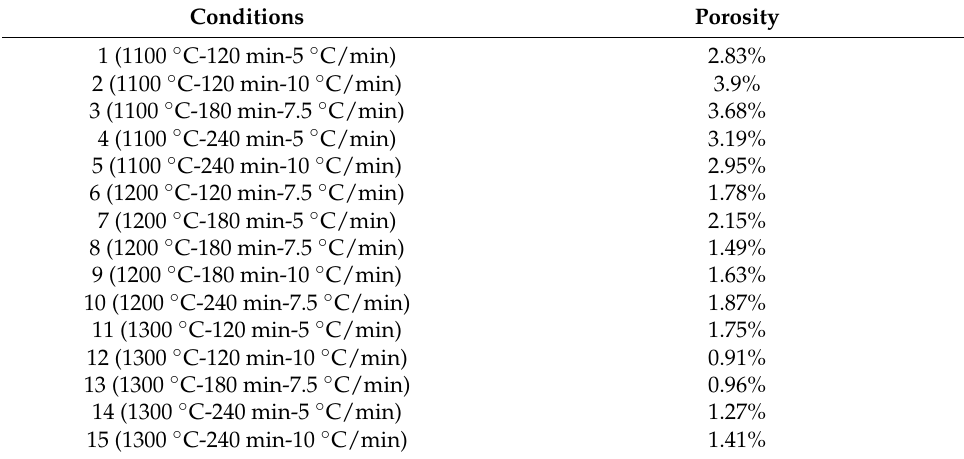
Figure 5. Pore morphology and distribution of these samples when sintered at various conditions. Table 2. Porosity statistics of these samples when sintered at various conditions. Conditions